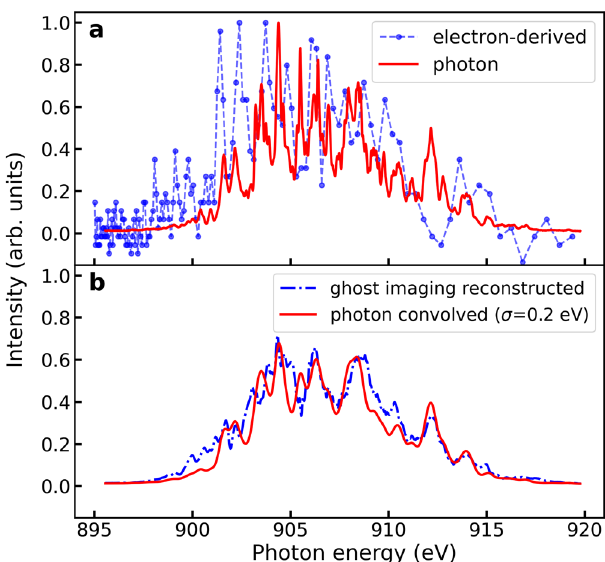
Fig. 3 Improved single-shot spectral retrieval using the ghost-imaging algorithm. Single-shot electron spectra before ( a ) and after ghost-imaging reconstruction ( b ) are shown in blue compared to photon spectra in red. Top panel ( a ) shows the raw electron-based spectrum from a single eToF (blue dashed line) and grating-based photon spectrum (red solid line). Lower panel ( b ) shows the ghost-imaging-reconstructed electron spectrum (blue dot-dashed line) and the photon spectrum after convolution with a Gaussian ( e (cid:2) x 2 = ð 2 σ 2 Þ with σ = 0.2 eV (red solid line).